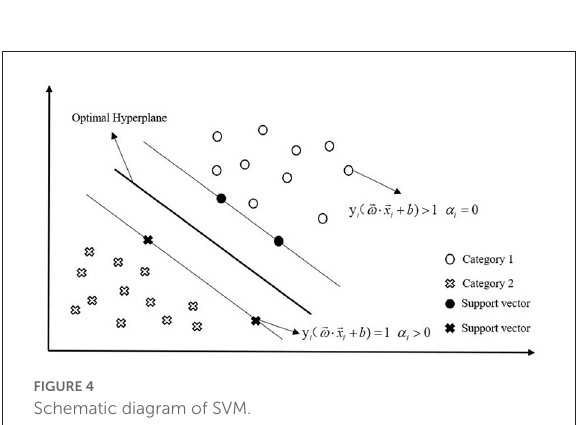
FIGURE4 Schematic diagram of